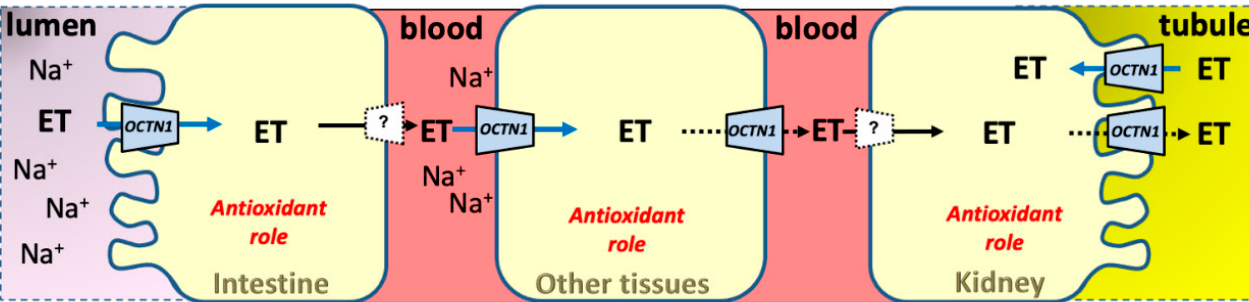
Figure 3. Metabolism and cellular role of the OCTN1 hypothesized substrate Ergothioneine ET. Epithelial polarized and other tissues are depicted as brushed or normal shapes. Intestine on the left, kidney on the right; other tissues in the middle. Intestine and tubular lumens are depicted in pink and yellow, respectively. Blood is depicted in red. Continuous arrows describe the OCTN1 transport of Ergothioneine, dotted arrows refer to a very low transport rate. Dotted lines represent other transporters than OCTN1. Transport regulation by sodium and adenosine triphosphate is reported.